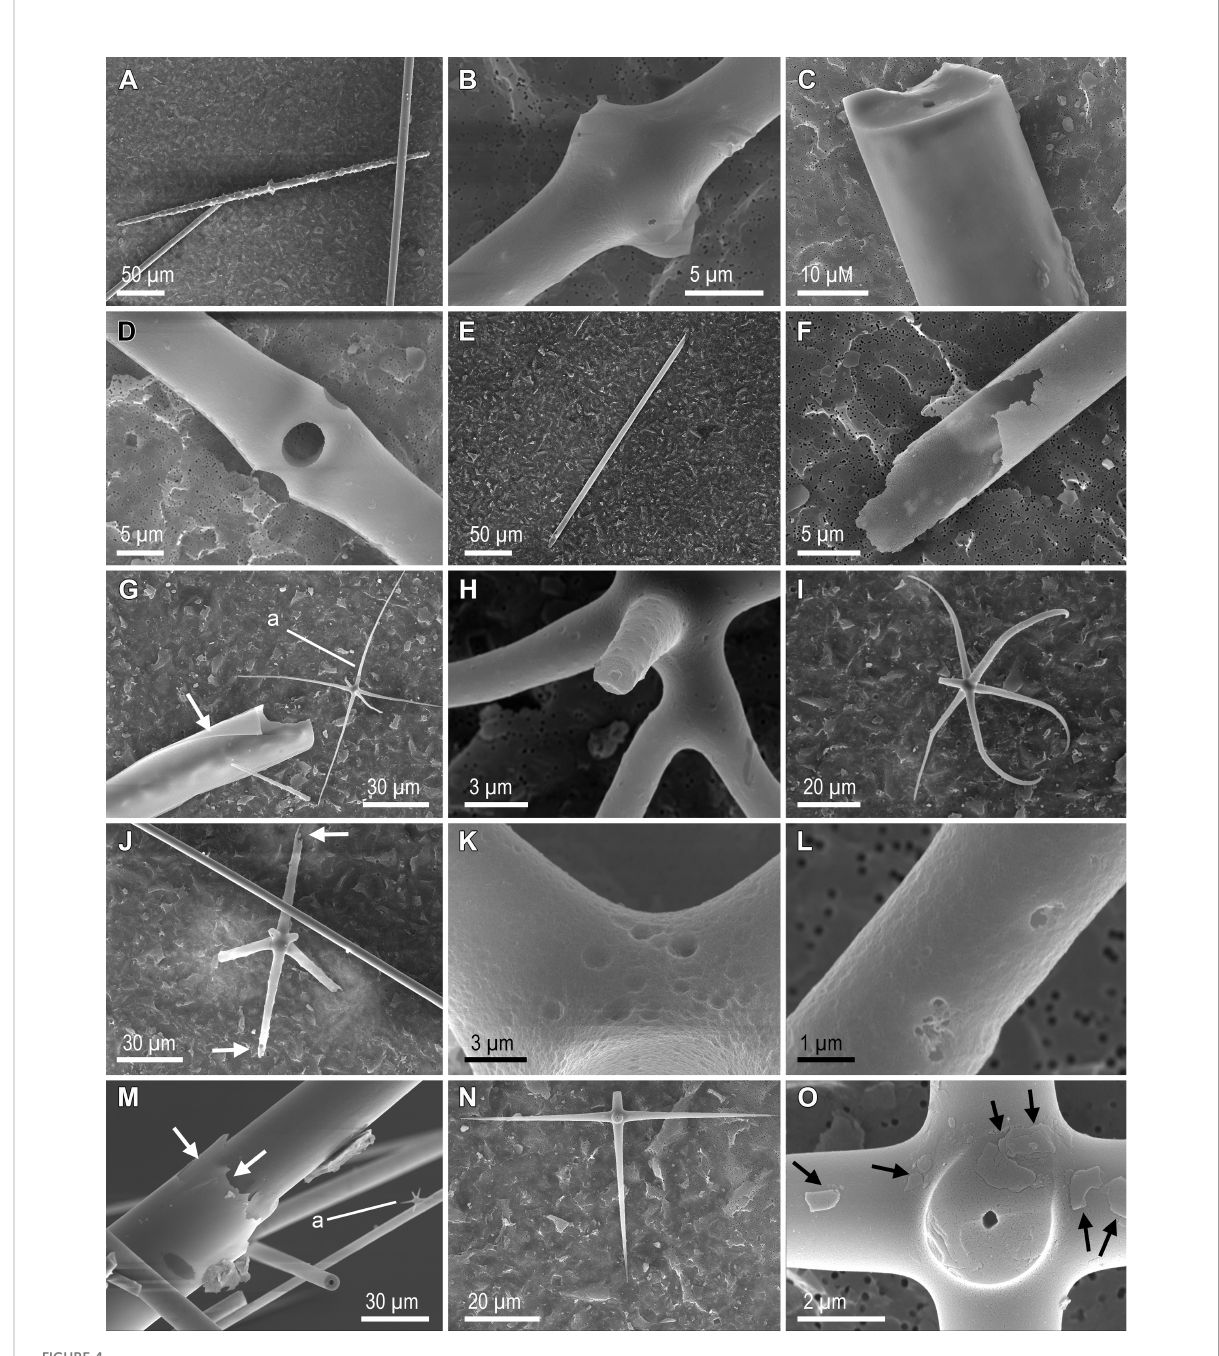
FIGURE 4 Scanning electron microscopy images of sponge skeletal pieces after 6 h and 24 h in 1% sodium carbonate at 85°C. Dermal (A, B) and choanosomal (A, C) diactines of hexactinellid Schaudinnia rosea showing weak dissolution at 6 h, but more extensive dissolution after 24 h (D – F) . Unlike the large spicules, the tiny asters (A) remained largely un dissolved after both 6h (G, H) and 24 h (I) . Note in G the occurrence of an undissolved peripheral layer (arrow) delaminated from a large choanosomal diactine. Hexactine (J, K) and diactine (J, L) of hexactinellid Asconema setubalense , showing moderate signs of dissolution at 6 h. The dissolution is more evident in the hexactine, with both more pronounced etching at the surface (K) and also inside the tips of the actines (arrows in J). (M) A combination of dermal and choanosomal diactines of hexactinellid Vazella pourtalesii , along with a tiny aster (a), all remaining largely undissolved after 6 h. Note signs of delamination of the peripheral silica layers (arrows). (N) Hexactine of V. pourtalesii remaining largely undissolved at 6 h, although with evidence (O) that the most peripheral silica layer (arrows) has been partially